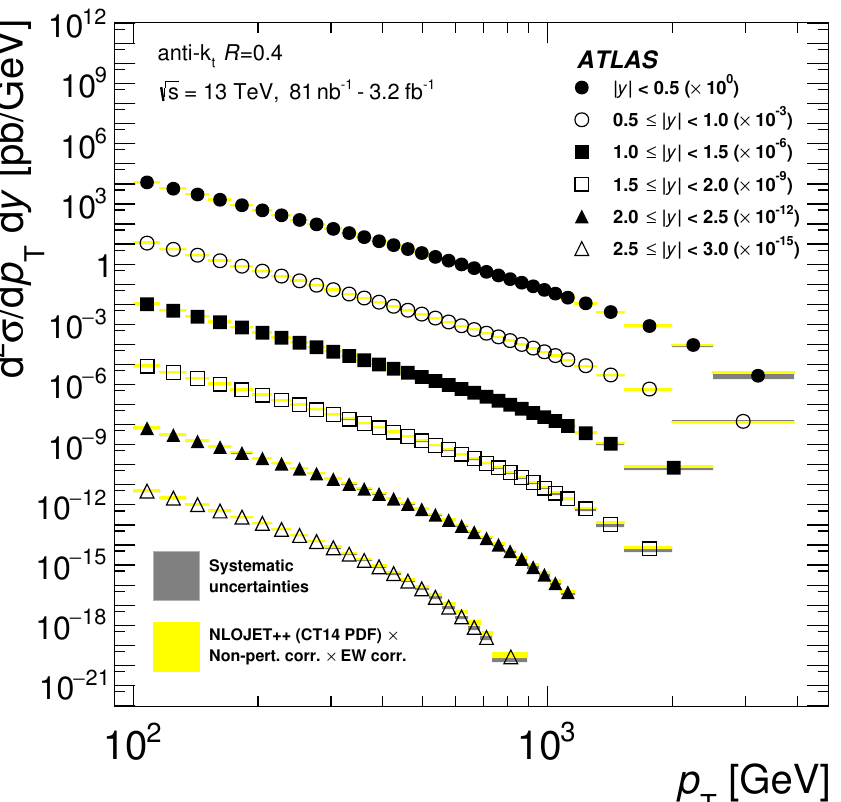
Figure 5 . Inclusive jet cross-sections as a function of p T and j y j , for anti- k t jets with R = 0 : 4. The statistical uncertainties are smaller than the size of the symbols used to plot the cross-section values. The dark gray shaded areas indicate the experimental systematic uncertainties. The data are compared to NLO pQCD predictions calculated using NLOJET++ with p max scale and the CT14 NLO PDF set, to which non-perturbative and electroweak corrections are applied. The light gray (yellow in the online version) shaded areas indicate the predictions with their uncertainties. At low and intermediate p T bins the experimental systematic uncertainties are comparable to the theory uncertainties (drawn on top) and therefore are barely